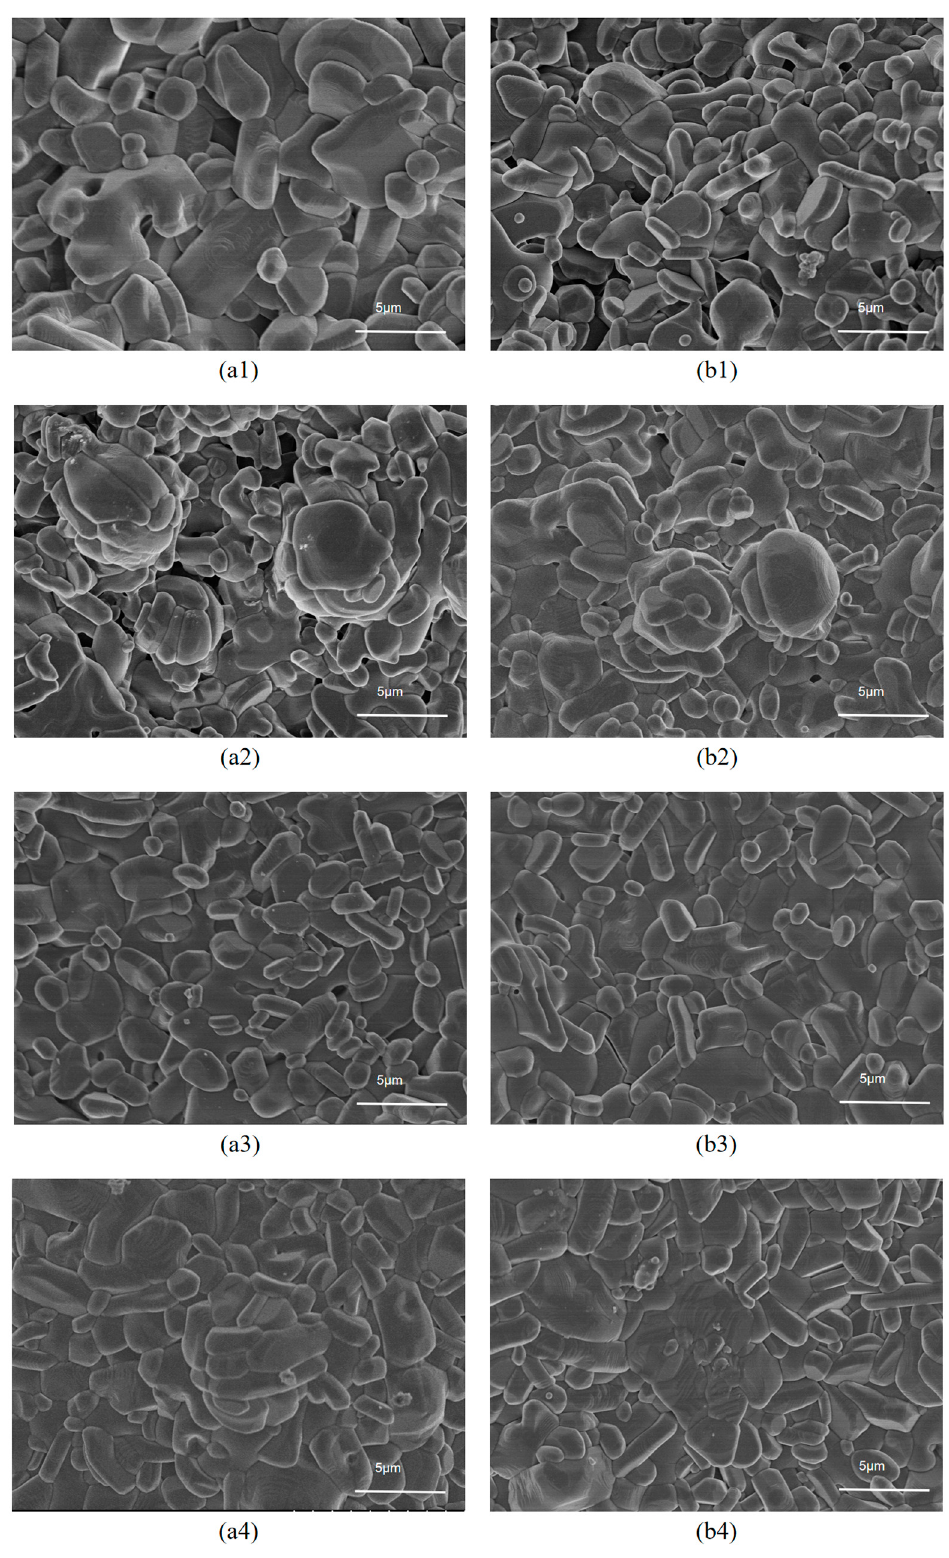
Figure 8. SEM images of 0.9 Al 2 O 3 -0.1 TiO 2 ceramics sintered at ( a1 ) 1400 ◦ C, ( a2 ) 1500 ◦ C, ( a3 ) 1550 ◦ C, ( a4 ) 1600 ◦ C. ( b1 – b4 ) are post-annealed samples of ( a1 – a4 ), respectively.